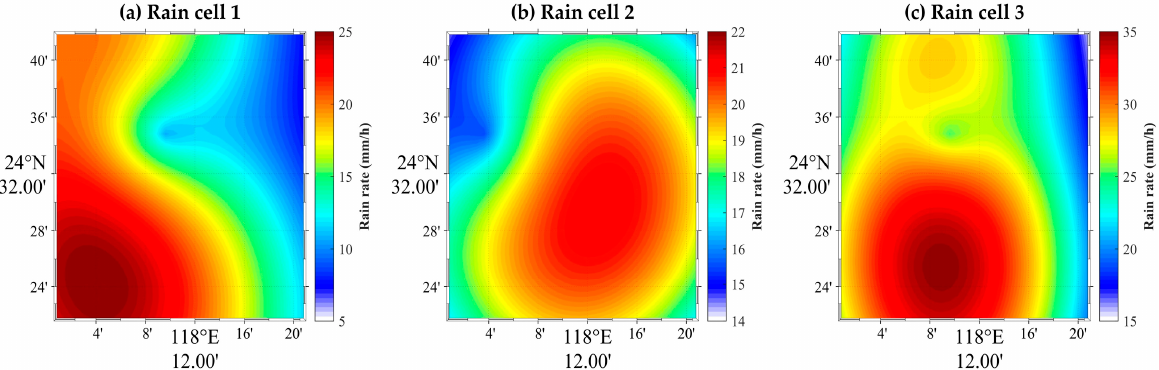
Figure 6. The set of different rain cells in the area. ( a ) is rain cell 1, indicating that the rain cluster has not yet fully entered the area. ( b ) is rain cell 2, indicating that the rain cluster has fully moved into the area. Additionally, ( c ) is rain cell 3, indicating that the rain cluster has split into two centers of rain rate.